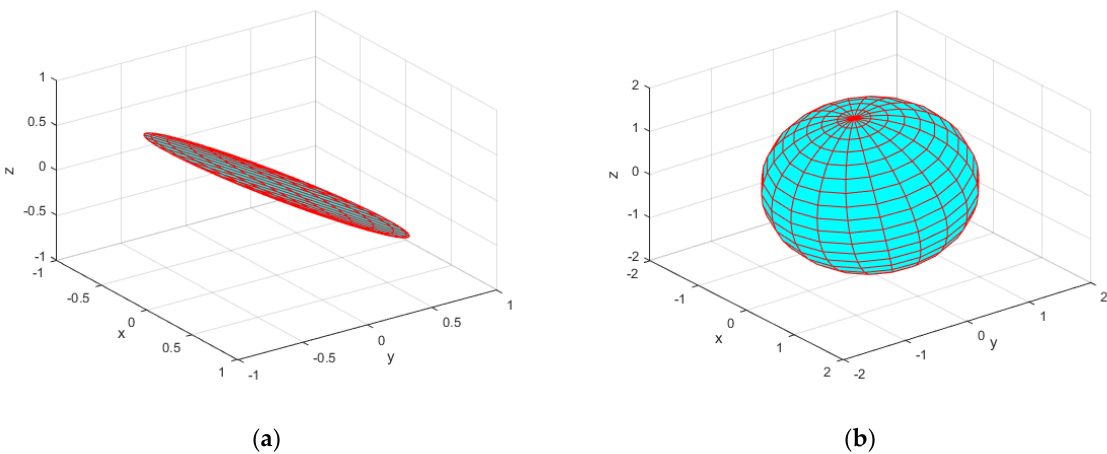
Figure 12. The EE translational velocity and rotational velocity ellipsoids.